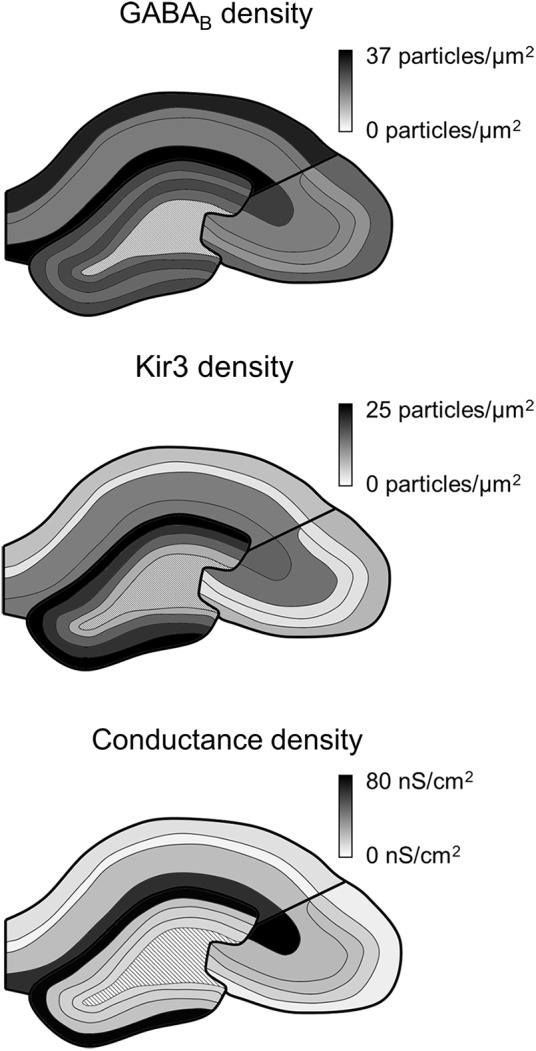
Summary of GABAB receptor and Kir3 effector channel and conductance density distributions in the hippocampus. Schematic overviews of the hippocampus show the density of immunogold labeling for GABAB receptor (top) and Kir3 channels (middle) as well as for conductance densities derived in the simulations (bottom). Boundaries of the hippocampal areas CA1, CA3, and DG as well as their layers are delineated in black; dark to light tones correspond to high to low densities (see scale bars to the right).